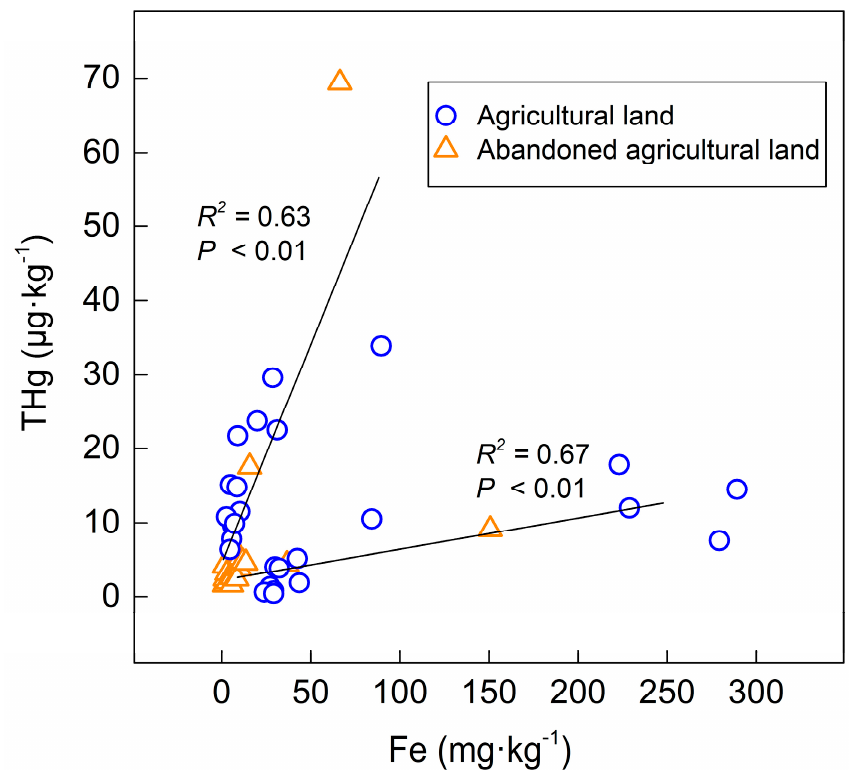
Figure 5. The relationships between the Fe content and THg in the agricultural land.